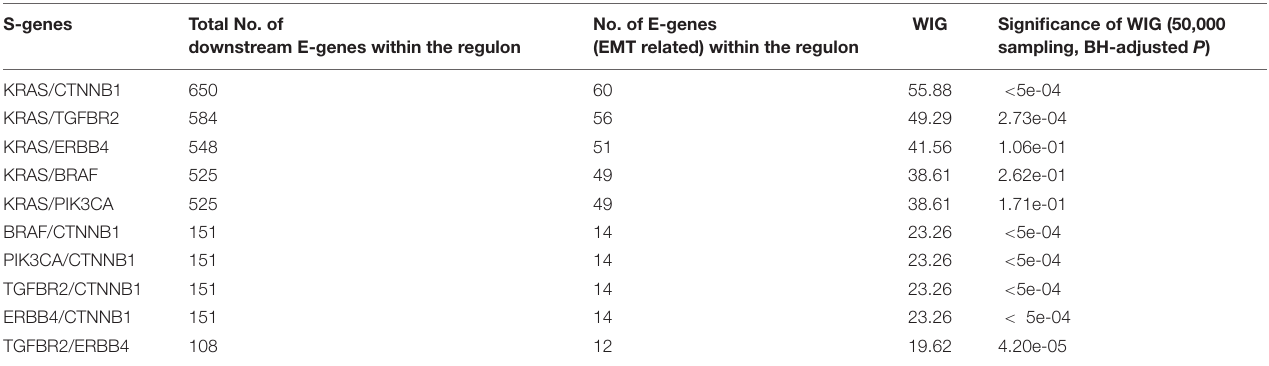
No. of E-genes (EMT related) within the regulon